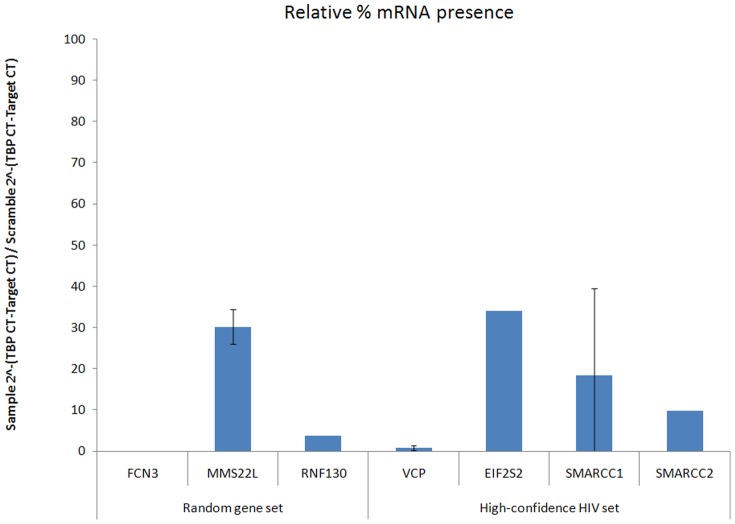
Validation of mRNA knock-down by siRNAs found to alter HIV infection.293T cells were transfected with siRNA against the identified genes and two non-targeting scramble siRNAs. 72 h post-transfection, total RNA was harvested and used to make a cDNA library. The presence of the target gene and a housekeeping gene, TBP, was measured using QPCR. Target gene levels were normalized to TBP within in each sample. Values reported are normalized target gene levels compared to values observed in transfections with non-targeting scramble siRNAs.